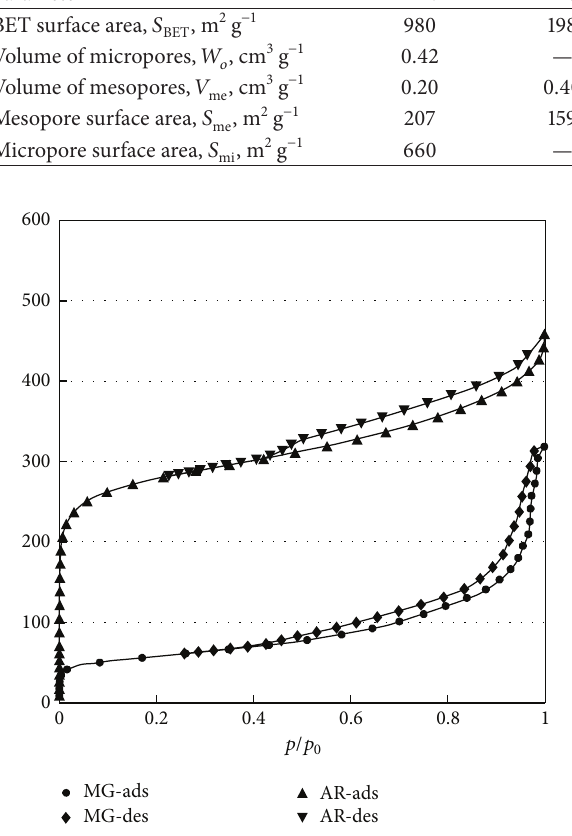
Figure 2: Nitrogen adsorption isotherms on MG and AR adsor-